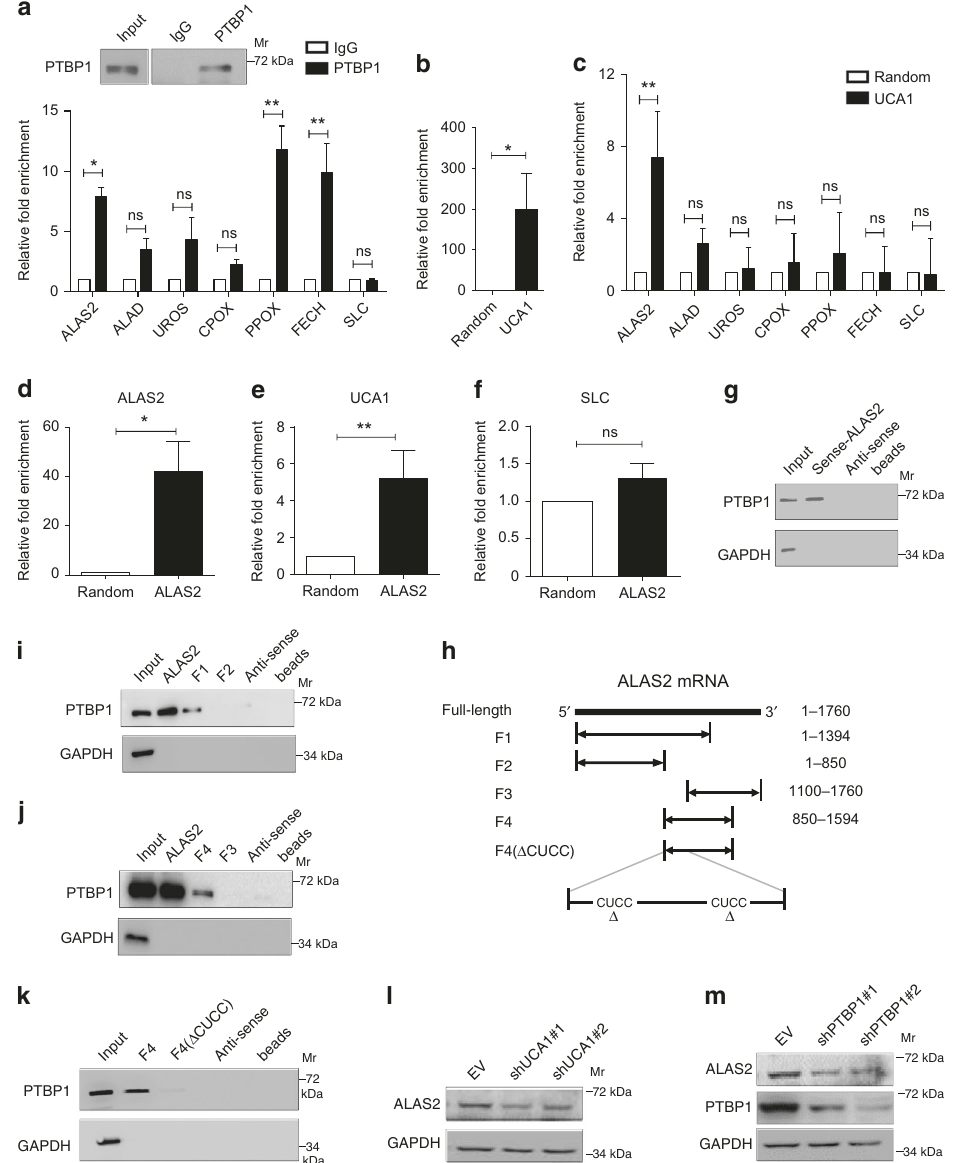
Fig. 5 PTBP1 protein, UCA1 RNA, and ALAS2 mRNA form a protein – RNA complex. a PTBP1 RIP assay to analyze interactions between PTBP1 and heme biosynthesis-related genes in HUDEP-2 cells. WB shows PTBP1 immunoprecipitation (top). The relative fold enrichment of heme biosynthesis-related mRNAs compared to IgG was determined by qRT-PCR (bottom). SLC was used as a negative control. b , c The enrichment of UCA1 ( b ) and heme biosynthetic mRNAs detected by in vivo RNA – RNA pull-down assay using UCA1 -speci fi c probes and a random probe in HUDEP-2 cells. SLC was used as a negative control. d – e The enrichment of ALAS2 mRNA ( d ), UCA1 ( e ) and SLC ( f ) by the in vivo RNA – RNA pull-down assay using ALAS2 -speci fi c probes in HUDEP-2 cells. SLC was used as a negative control. g WB using anti-PTBP1 antibody followed by in vitro transcribed ALAS2 and antisense- ALAS2 mRNA pull-down assay in HUDEP-2 cells. GAPDH was used as a negative control. h – k In vitro transcribed full-length or fragmental ALAS2 mRNA pull-down assays followed by PTBP1 immunoblotting in AraC-induced K562 cells ( i , j ) and HUDEP-2 cells ( k ). We have in vitro transcribed full-length ALAS2 , from 5 ʹ F1 (1 – 1394 nt), F2 (1 – 850 nt), F3 (1100 – 1760 nt), F4 (850 – 1594 nt), F4 fragment with PTBP1-binding motif deletion (F4( Δ CUCC)) and full-length antisense- ALAS2 mRNA. GAPDH was used as a negative control. l , m WB shows ALAS2 expression after UCA1 ( l ) and PTBP1 ( m ) depletion in primary erythroid cells differentiated for 8 days. GAPDH was used as a loading control. n = 3 independent experiments. Error bars represent SEM. P -values were determined by Student ’ s t -test. *P < 0.05, **P <